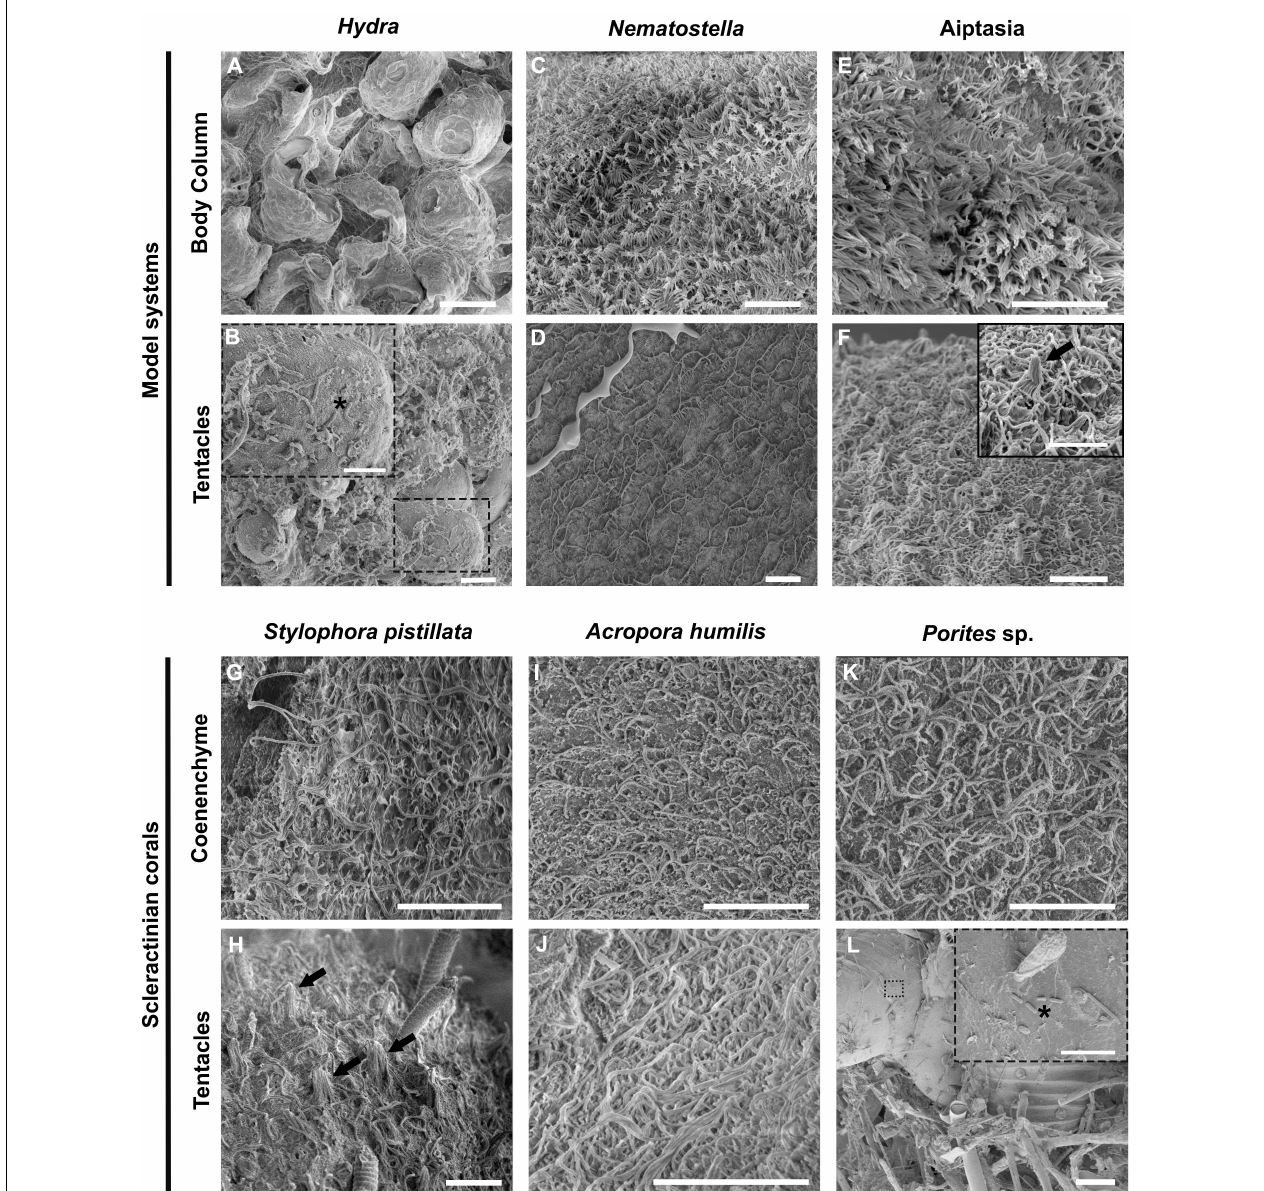
FIGURE 1 | Ultrastructural comparison of the surface topography of Hydra and Anthozoans. Representative scanning electron microscopy (SEM) images of three model cnidarians (A–F) and three reef building corals (G–L) show differences between the hydrozoan Hydra and anthozoans, but an overall similar topography across anthozoans. (A,B) Hydra column and tentacle surface topography. (C,D) Nematostella column and tentacle surface topography. (E,F) Aposymbiotic Aiptasia column and tentacle surface topography. (G,H) Stylophora pistillata coenenchyme and tentacle. (I,J) Acropora humilis coenenchyme and tentacle. Noticeable are the discharged cnidocysts in the tentacle. (K,L) Porites sp. coenenchyme and fouled surface topography. Note the presence of microeukaryotes trapped in the fouled region, to which bacteria seem attached. Dashed line boxes denote regions where bacteria can be seen (black asterisks). Black arrows